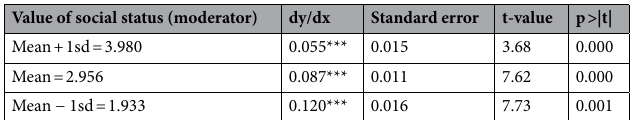
Table 7. Simple slope tests results (N = 14,116). ***p < 0.001, **p < 0.01, *p < 0.05.